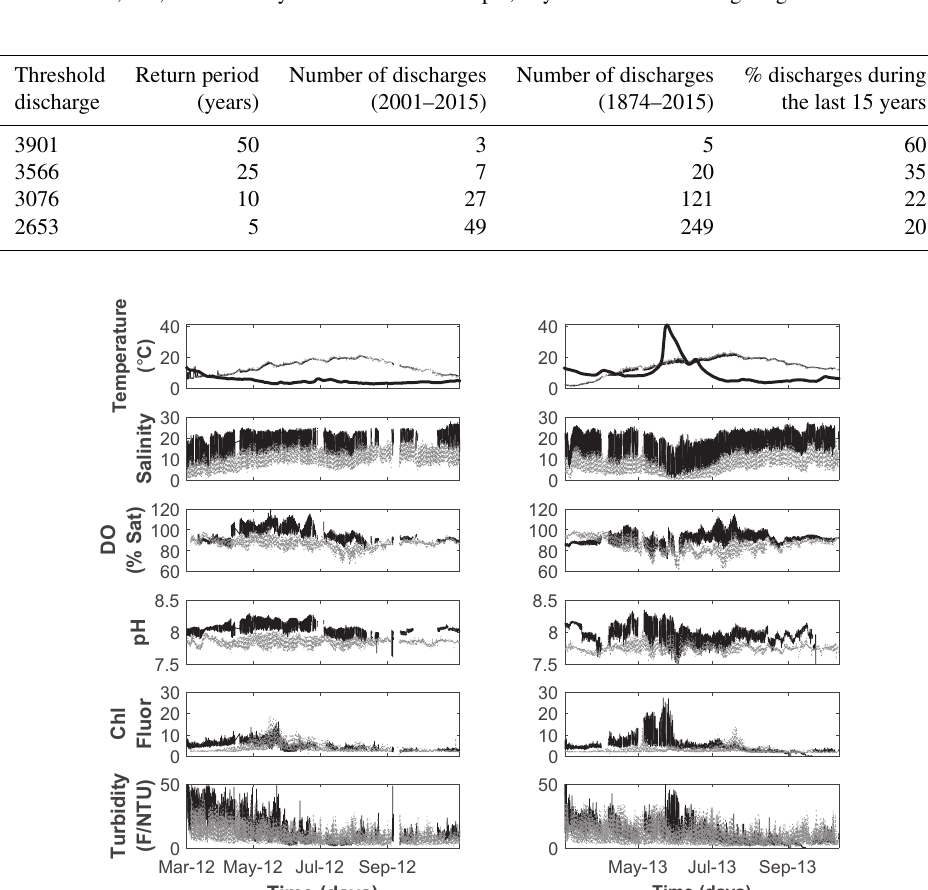
Figure 3. Hourly measurements of temperature, salinity, DO (% saturation), pH, chlorophyll (fluorescence) and turbidity (F/NTU), measured at Cuxhaven (725riverkm, black line) and HPA pile (710riverkm, gray line) in the Elbe estuary, for 2012 (left panels) and 2013 (right panels). As a reference, the Elbe discharge (m 3 s − 1 ) at Neu Darchau station (thick black line), scaled by dividing it by 100, was also included in the temperature